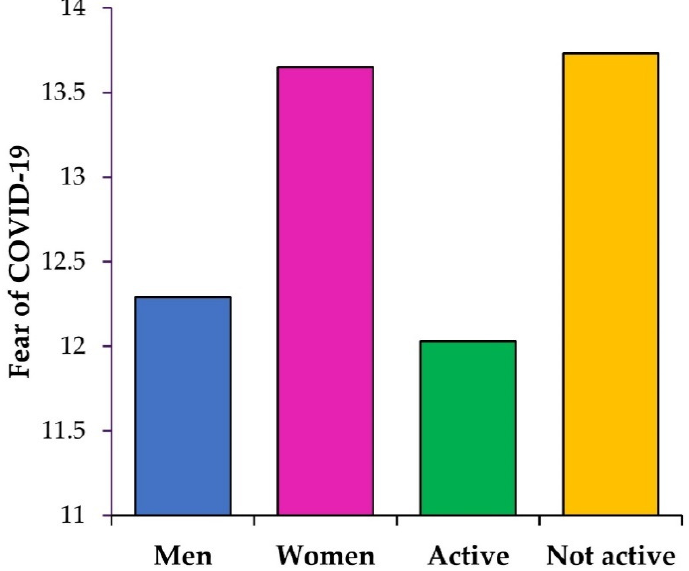
Figure 2. A comparison of mean scores in fear of COVID-19 among women, men, and active and inactive university students.